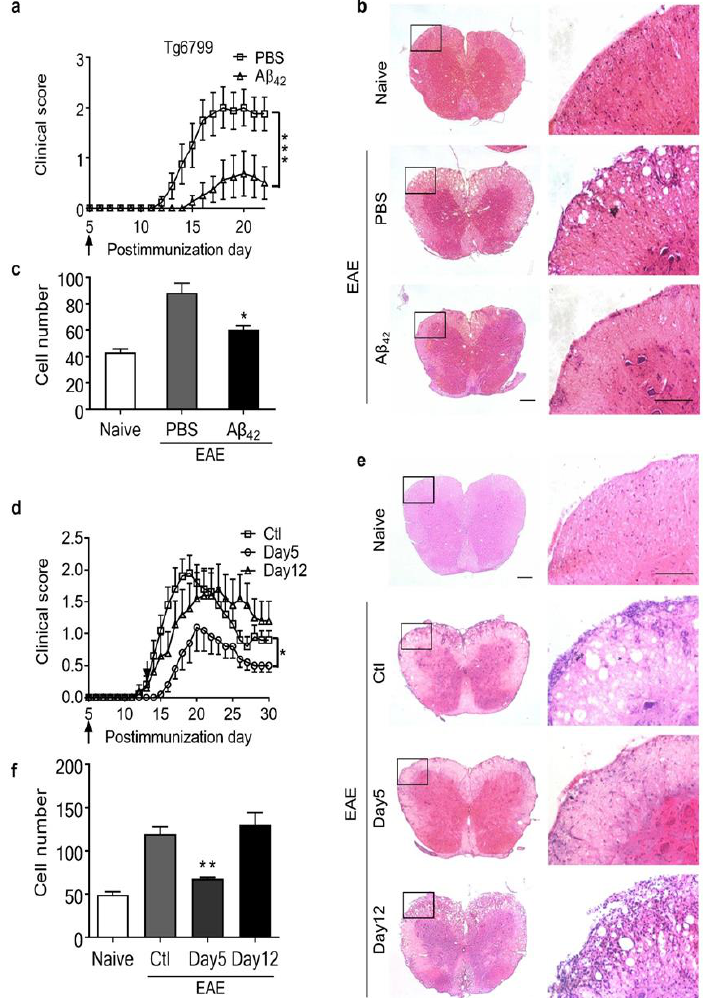
Figure 3. Reduction in EAE clinical symptoms by intraperitoneal injection of A β 42 peptides. ( a ) Clinical scores of EAE mice treated with A β 42 peptides or PBS in Tg6799 mice. EAE was induced in 10-week Tg6799 mice by immunization with MOG35–55 peptide, A β 42 peptides, or PBS, which were administered daily via intraperitoneal injection from day 5 postimmunization. Data are mean ± SEM, *** p < 0.001(PBS group, n = 9; A β 42 group, n = 9). ( b , c ) H&E staining of spinal cord sections and quantification of infiltrating cells. * p < 0.05 (Student’s t -test). ( d ) Clinical scores (mean ± SEM) of MOG-immunized mice treated with A β 42 peptides or PBS in 10-week C57BL/6J mice. A β 42 peptides or PBS were administered daily via intraperitoneal injection from day 5 or day 12 postimmunization. * p < 0.05 ( n = 10). ( e , f ) H&E staining of spinal cord sections and quantification of infiltrating cells. Data are mean ± SEM, ** p < 0.01 (Student’s t -test). The boxed areas in the left columns are presented enlarged on the right. Scale bars, 200 µ